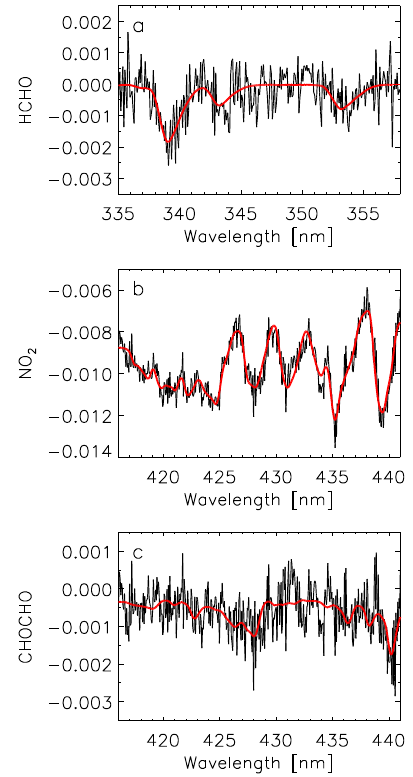
Fig. 1. Example of DOAS fit results for (a) HCHO, (b) NO 2 , and (c) CHOCHO. The evaluated spectrum was recorded on 19 July 2006 at 10:59LT, at α = 3 ◦ . Red line represents the fitted reference spectrum. Black line is the fit residual plus the absorption of the tar- get species. Detailed settings of the DOAS fit are listed in Table S1 in the